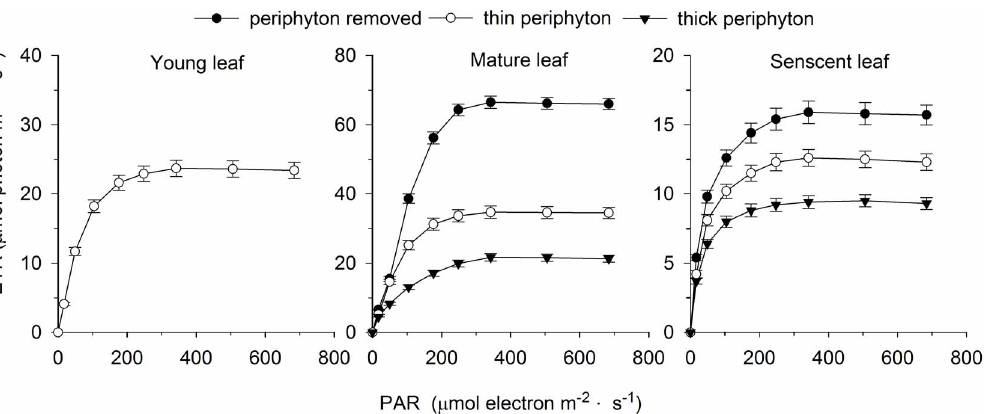
Figure 6. Rapid light curves of Potamogetonmalaianus with different biomass densities of periphyton. Values with bars indicate standard deviations, n=3.